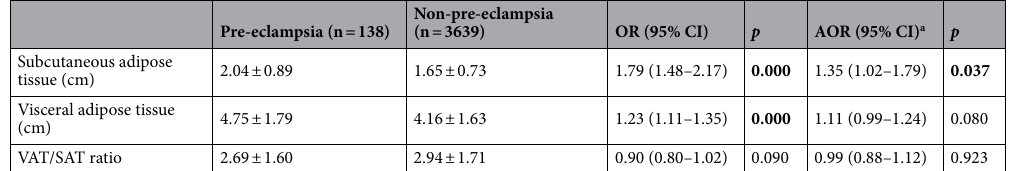
Table 2. Subcutaneous adipose tissue (SAT) thickness and visceral adipose tissue (VAT) thickness in women later developing and not developing pre-eclampsia. Odds ratio (OR) illustrates increased risk by every centimetre increase in tissue thickness. Data missing on SAT measurement on 2 patients and on VAT measurement on 6 patients. CI confidence Interval, VAT visceral adipose tissue, SAT subcutaneous adipose tissue. a Adjusted for maternal age, parity, BMI, smoking and country of